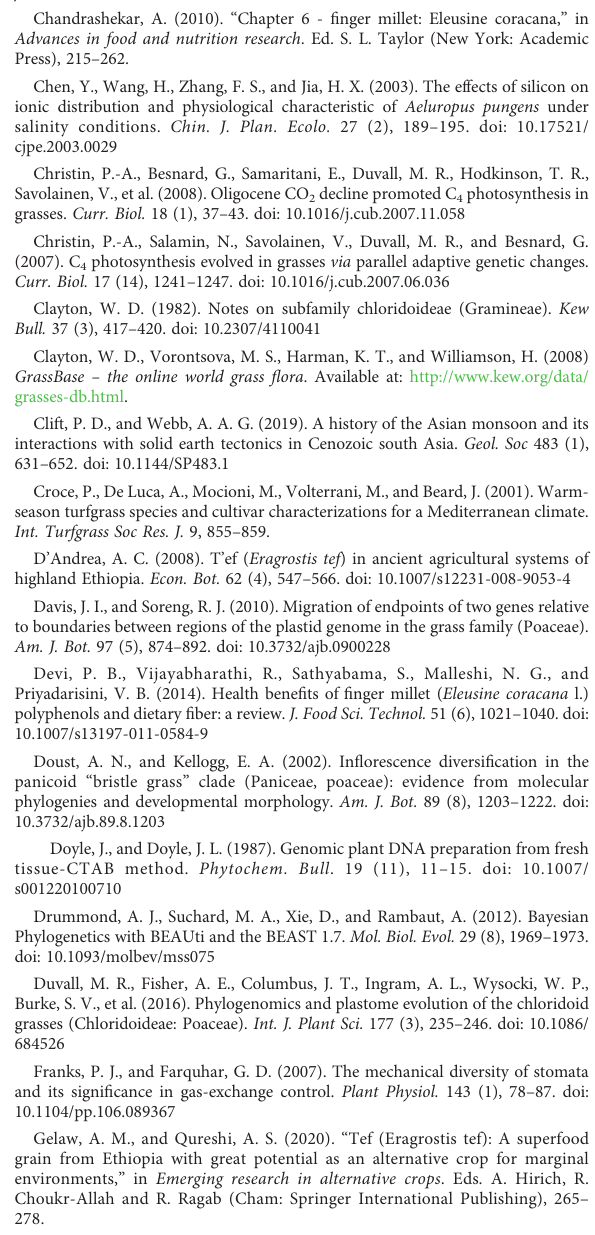
cell microhair with sharp-cap cell, (G) short equal-base-cell microhair with round-cap cell. Red scale bars: 20 m m. SUPPLEMENTARY FIGURE 7 Phytoliths found inChloridoideae. (A) square, (B) saddle, (C) oval, (D) short dumbbell type with square lobes, (E) four-lobes, cross, (F) two-lobed with no obvious rod-like structure, (G) short dumbbell type with round lobes, (H) long dumbbell type with round lobes. Red scale bars: 20 m